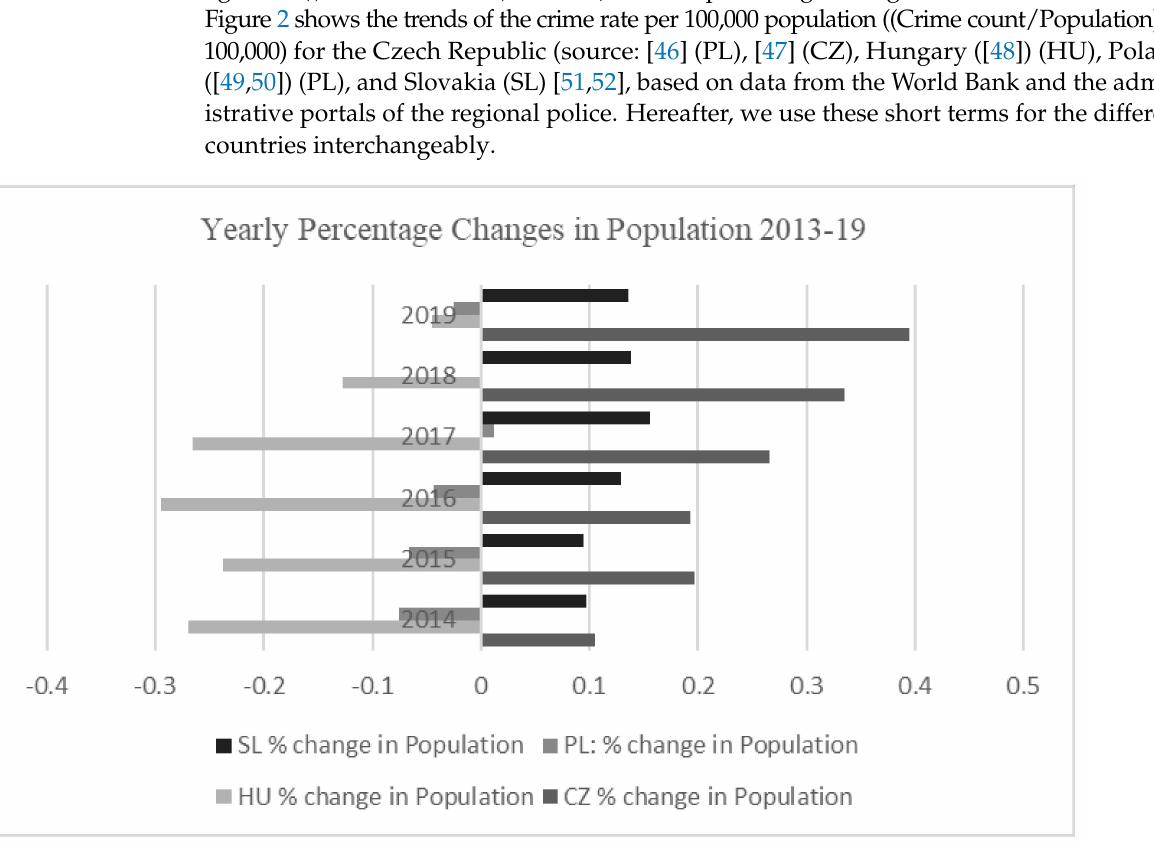
Figure 1. Changes in the population of V4 countries, as a percentage, for 2013–2019. Source: https: //data.worldbank.org/indicator/SP.POP.TOTL (accessed on 9 October